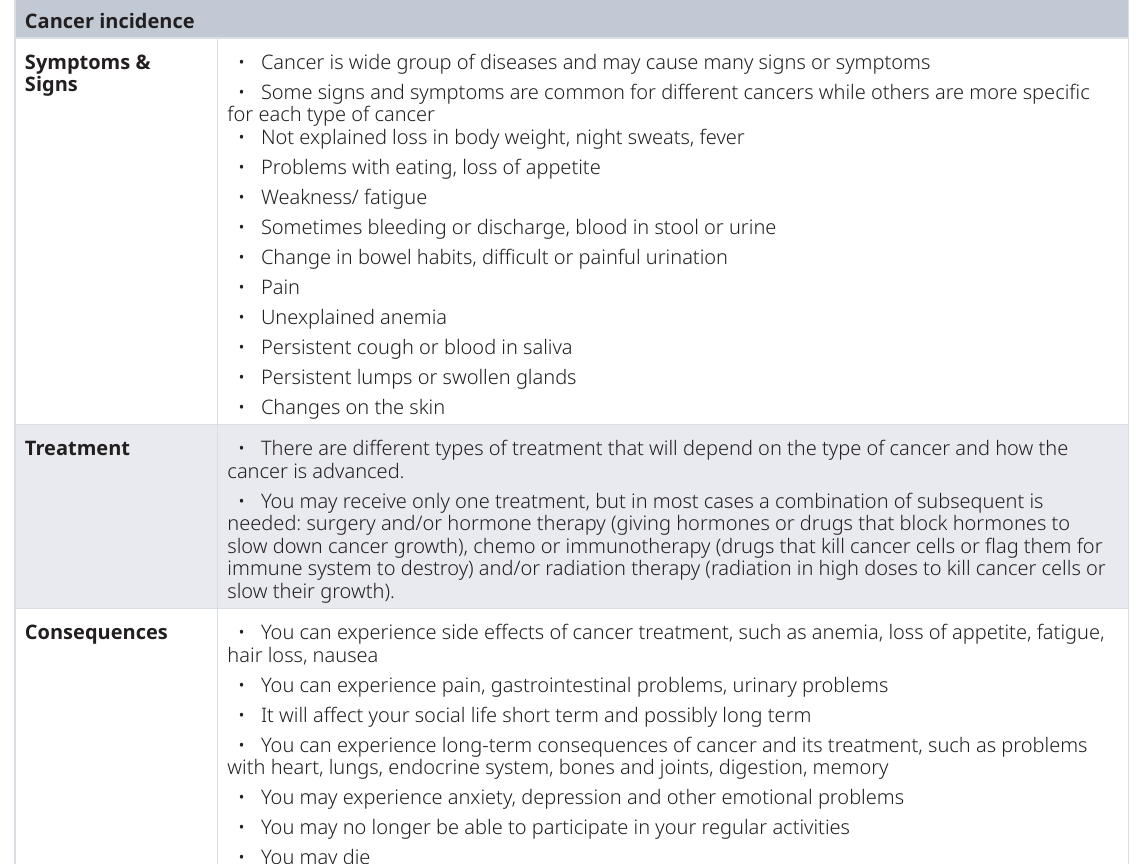
Table 1. Health states - Cancer